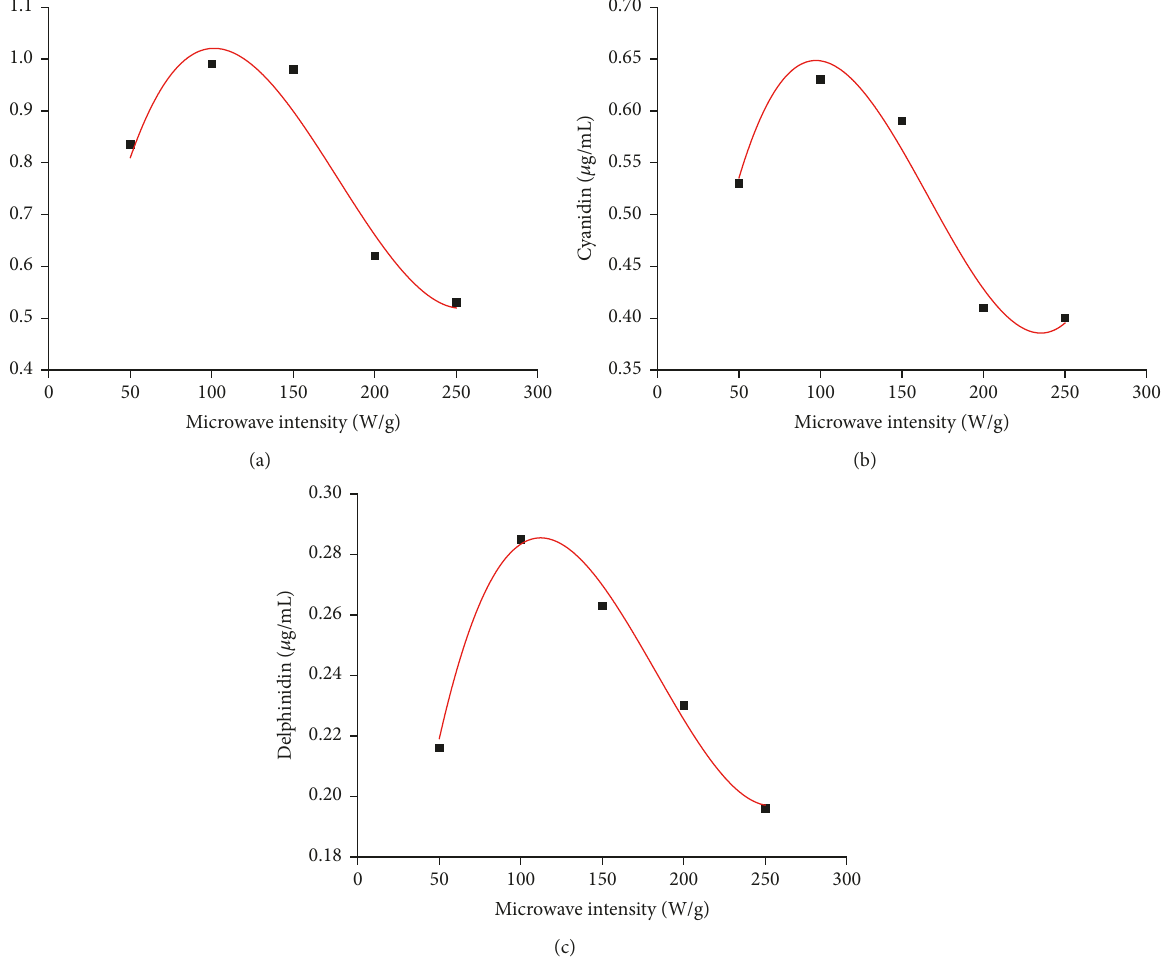
Figure 10: Effects of microwave intensities on the anthocyanin monomer (ethanol concentration of 60%, ratio of solid to liquid of 1: 30, and extraction time of 80s).